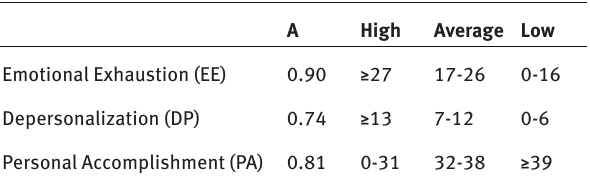
Table 1: Maslach Burnout Inventory subscales: internal consistency and normative